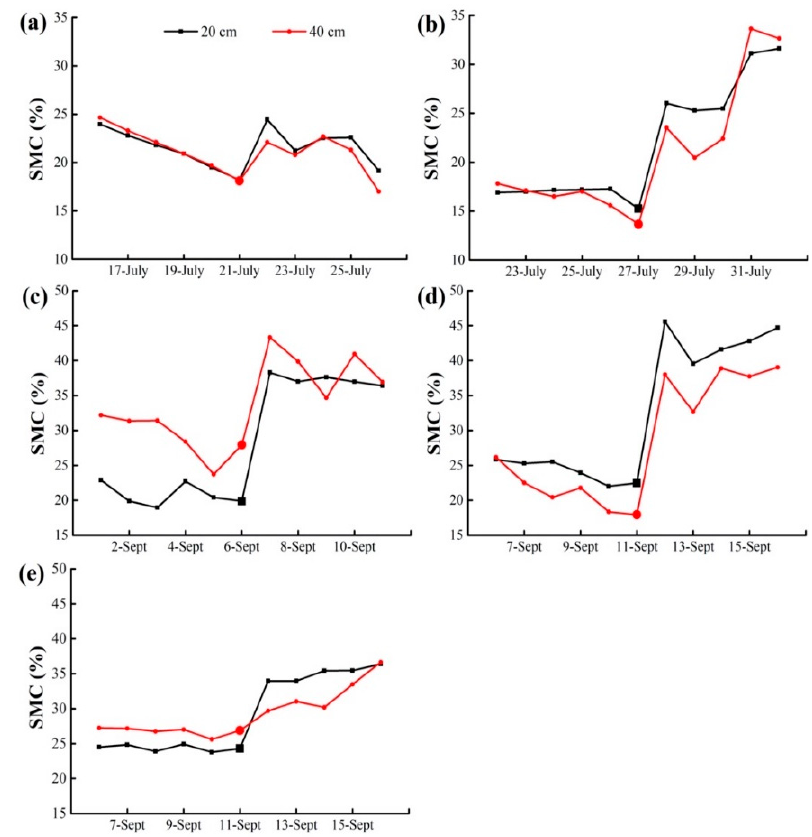
Figure 2. The soil moisture content during the DFAA period (five consecutive days before and after the rainfall). ( a ) DFAA1 treatment; ( b ) DFAA2 treatment; ( c ) DFAA3 treatment; ( d ) DFAA4 treatment; ( e ) CK treatment. The thicker points correspond to the rainfall date. SMC represents the soil moisture content, 20 cm represents the soil layer of 20 cm, 40 cm represents the soil layer of 40 cm.